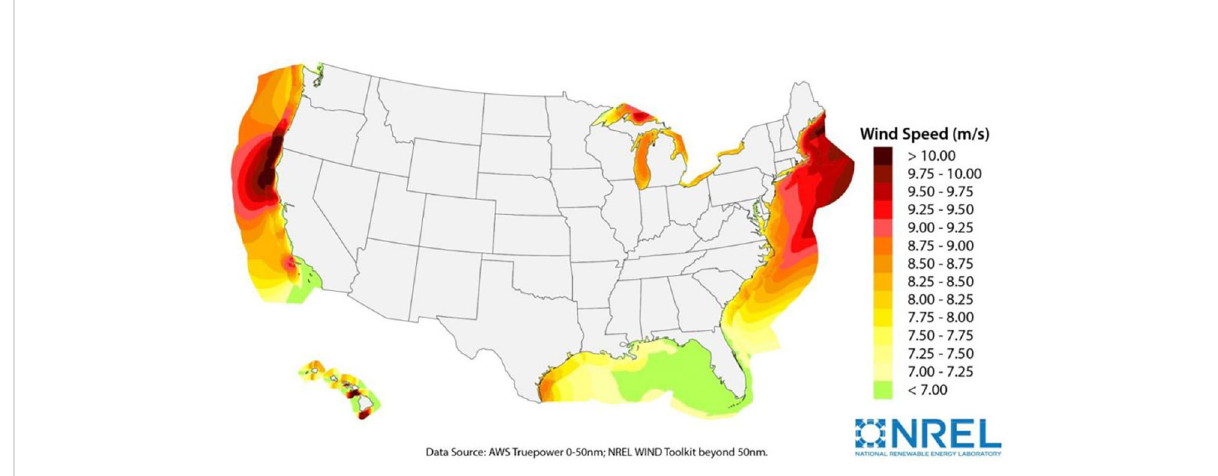
FIGURE 1 US annual average offshore wind speeds (Computing America ’ s Offshore Wind Energy Potential, https://www.energy.gov/eere/articles/